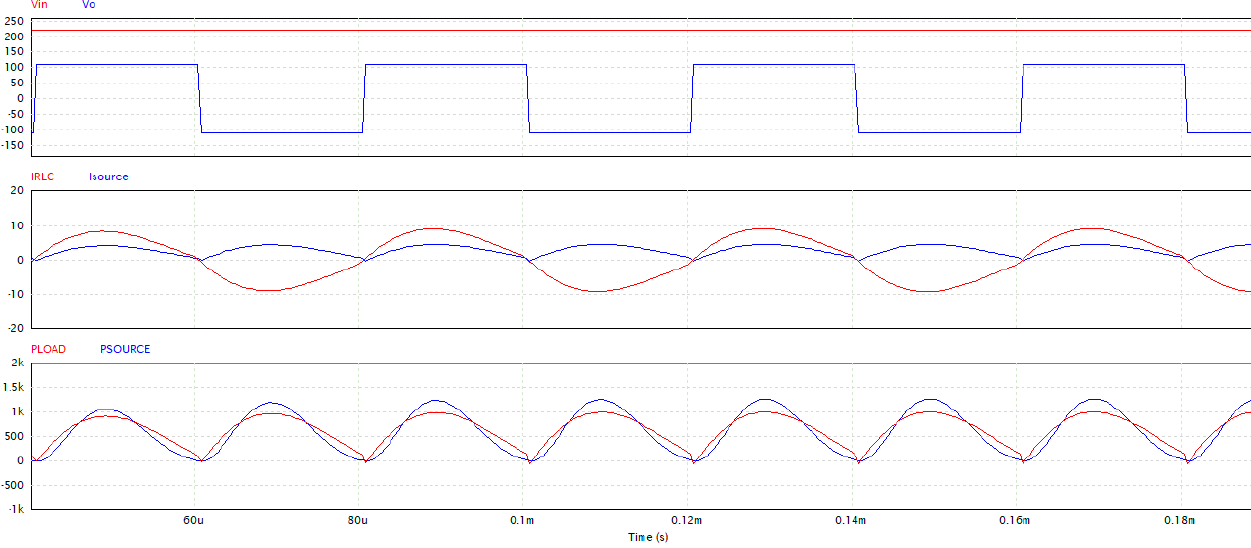
Figure 12. Power and voltage waveforms (input and output) for ferrous heating mode during simulation.